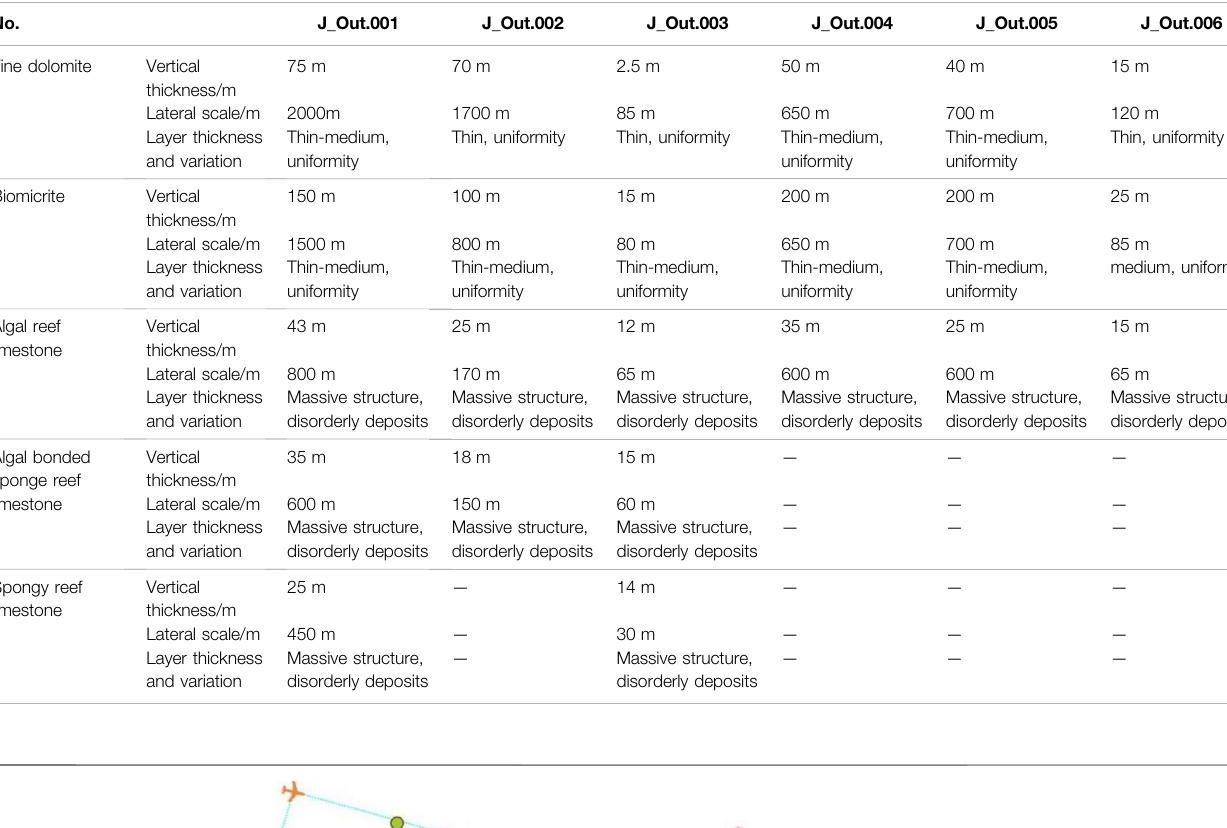
TABLE 1 | Quantitative parameters of lithofacies architecture in the outcrop area.